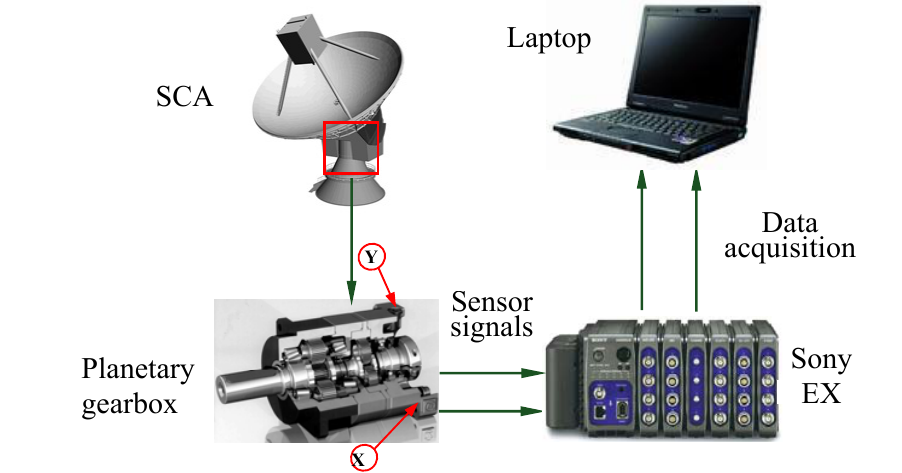
Figure 9. The testing framework of the SCA of a measurement ship.